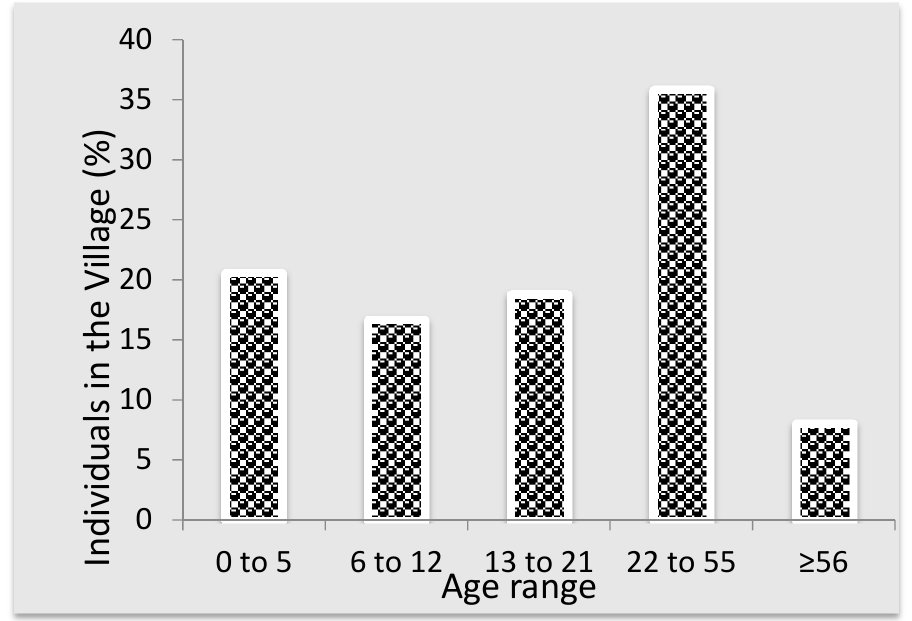
Figure 5. Population distribution of Makwane Village by major age groups.